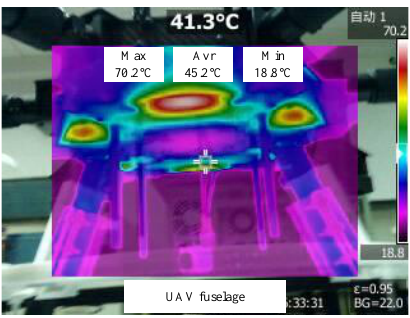
Figure 20. Carbon fiber fuselage temperature. (iii) With UAV and Nanocrystalline